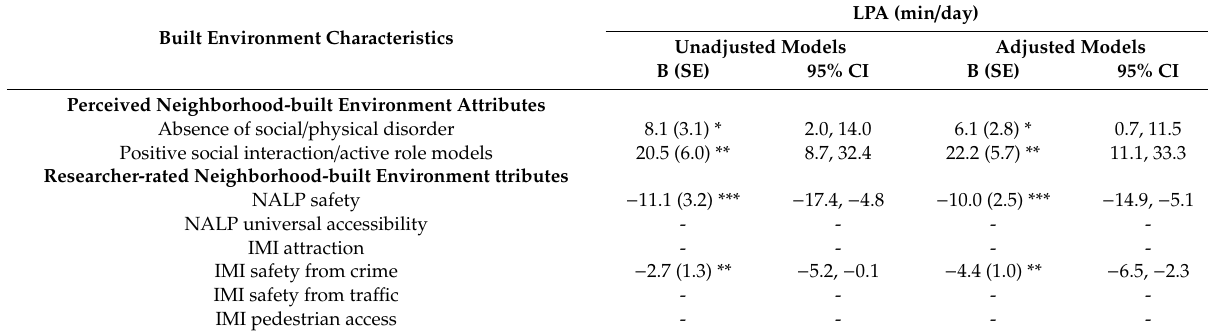
Table 3. Associations between BE characteristics and average daily minutes of LPA (only significant associations from the final model presented).